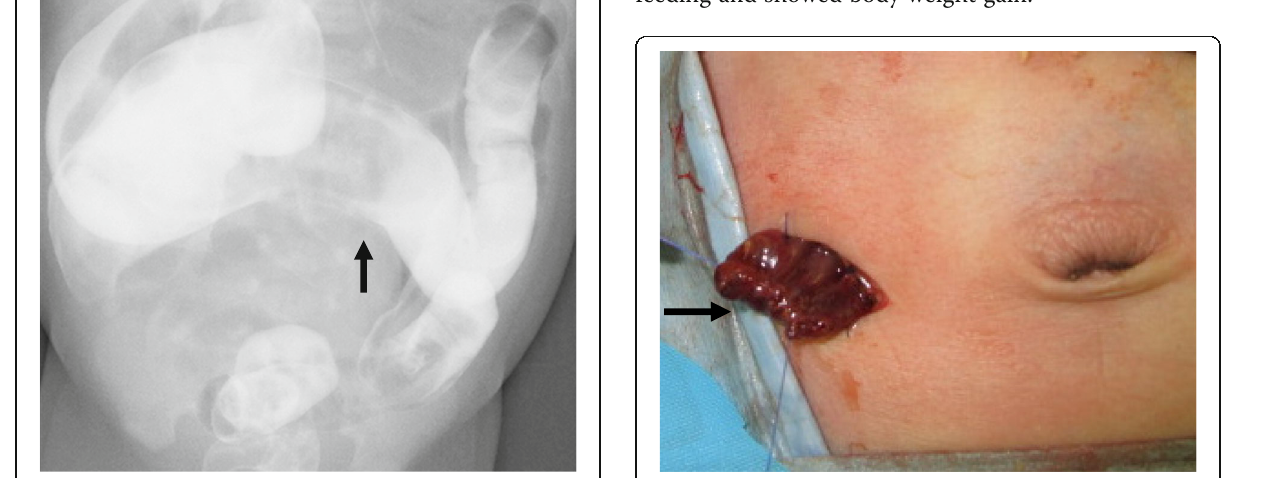
Fig. 3 Blowhole tangential cecostomy by the perforation site of the cecum